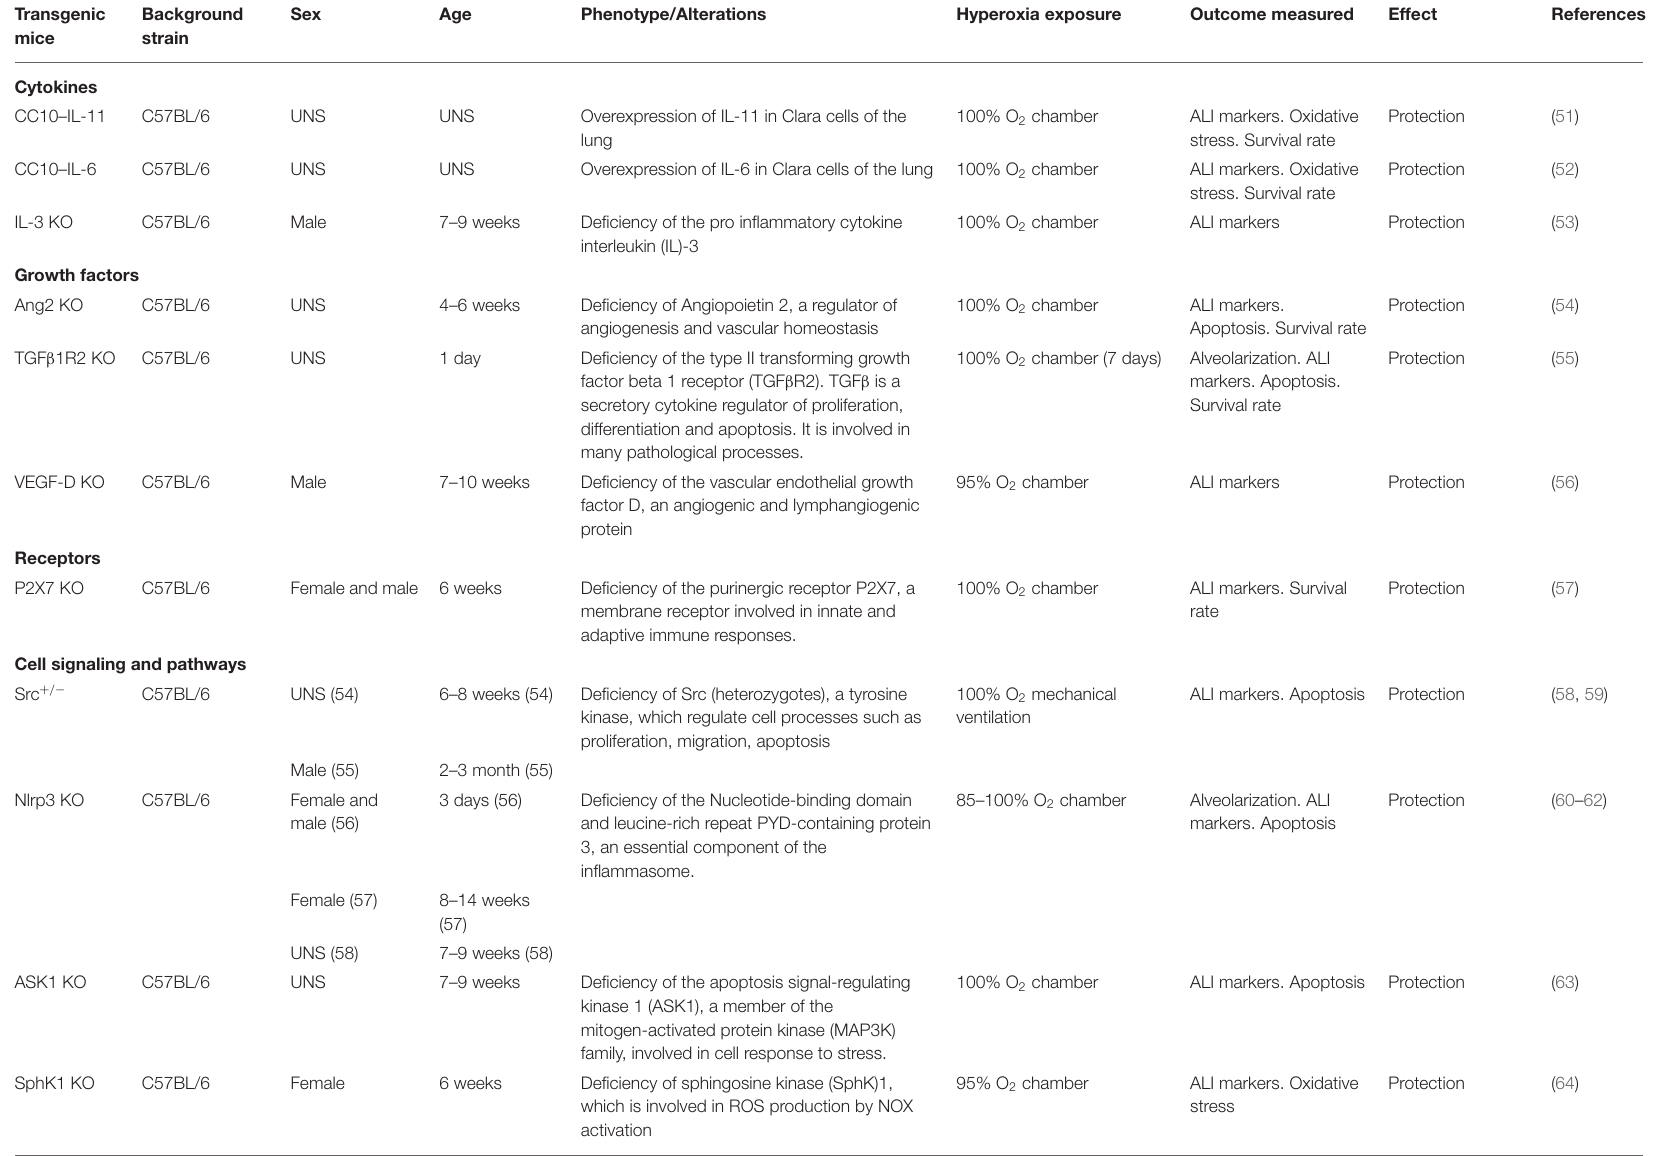
TABLE 1 | Transgenic mice and susceptibility to